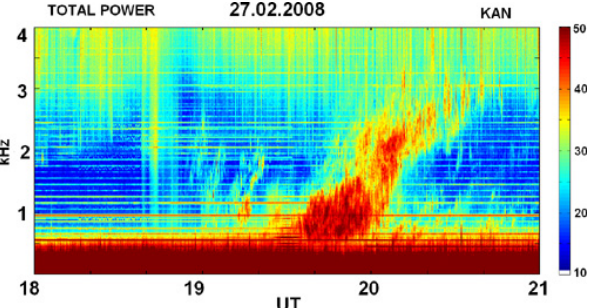
Fig. 1. Spectrogram of the chorus event on 27 February 2008.